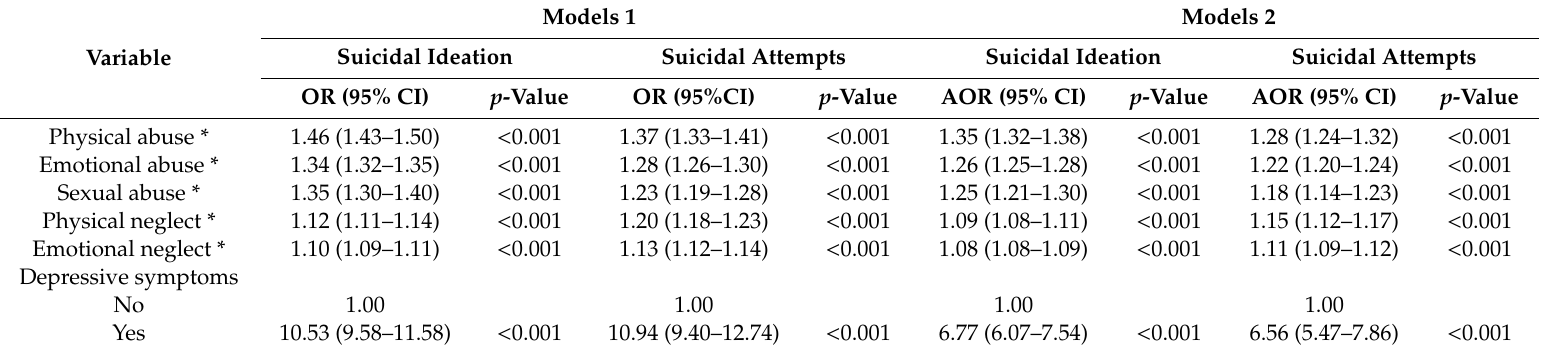
Table 2. Association of childhood maltreatment and depressive symptoms with